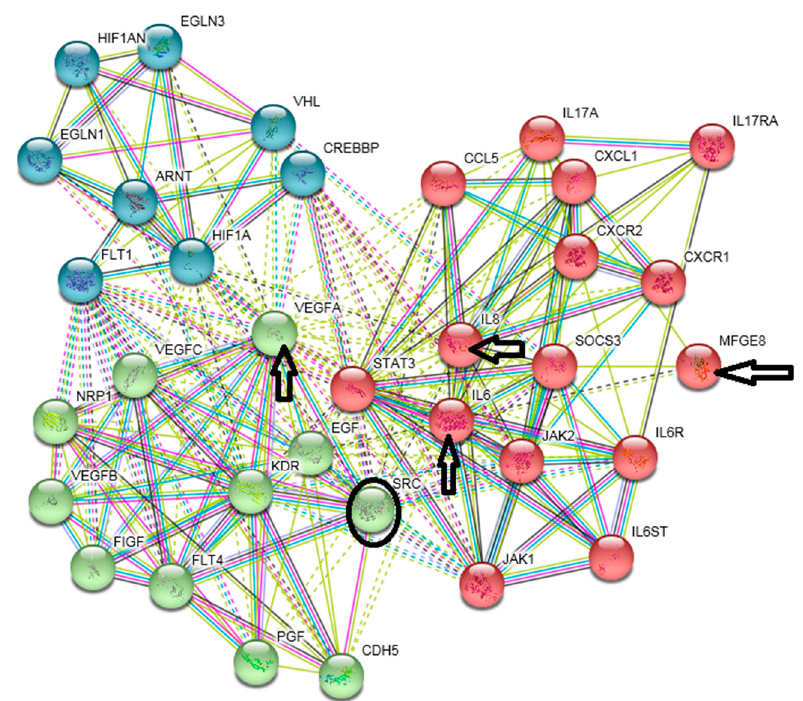
Figure 5. Combinatorial targeting of several signalling pathways. The figure shows the protein interaction analysis (https://string-db.org/) of IL-6, IL-8, VEGF-A and MFGE-8 (indicated by arrows). The circle delineates the SRC protein. Green nodes denote proteins associated with vascularisation, red nodes denote proteins of IL-6/STAT-3 and IL-8 signalling, and blue nodes denote proteins associated with resistance to hypoxia. The links in the diagram indicate experimental or literature association of the proteins. Links in the solid (or dashed) line indicate interactions within (or between) signalling pathways. MFGE-8 also plays a role in the interaction between cancer cells and tumour-associated macrophages (TAM).